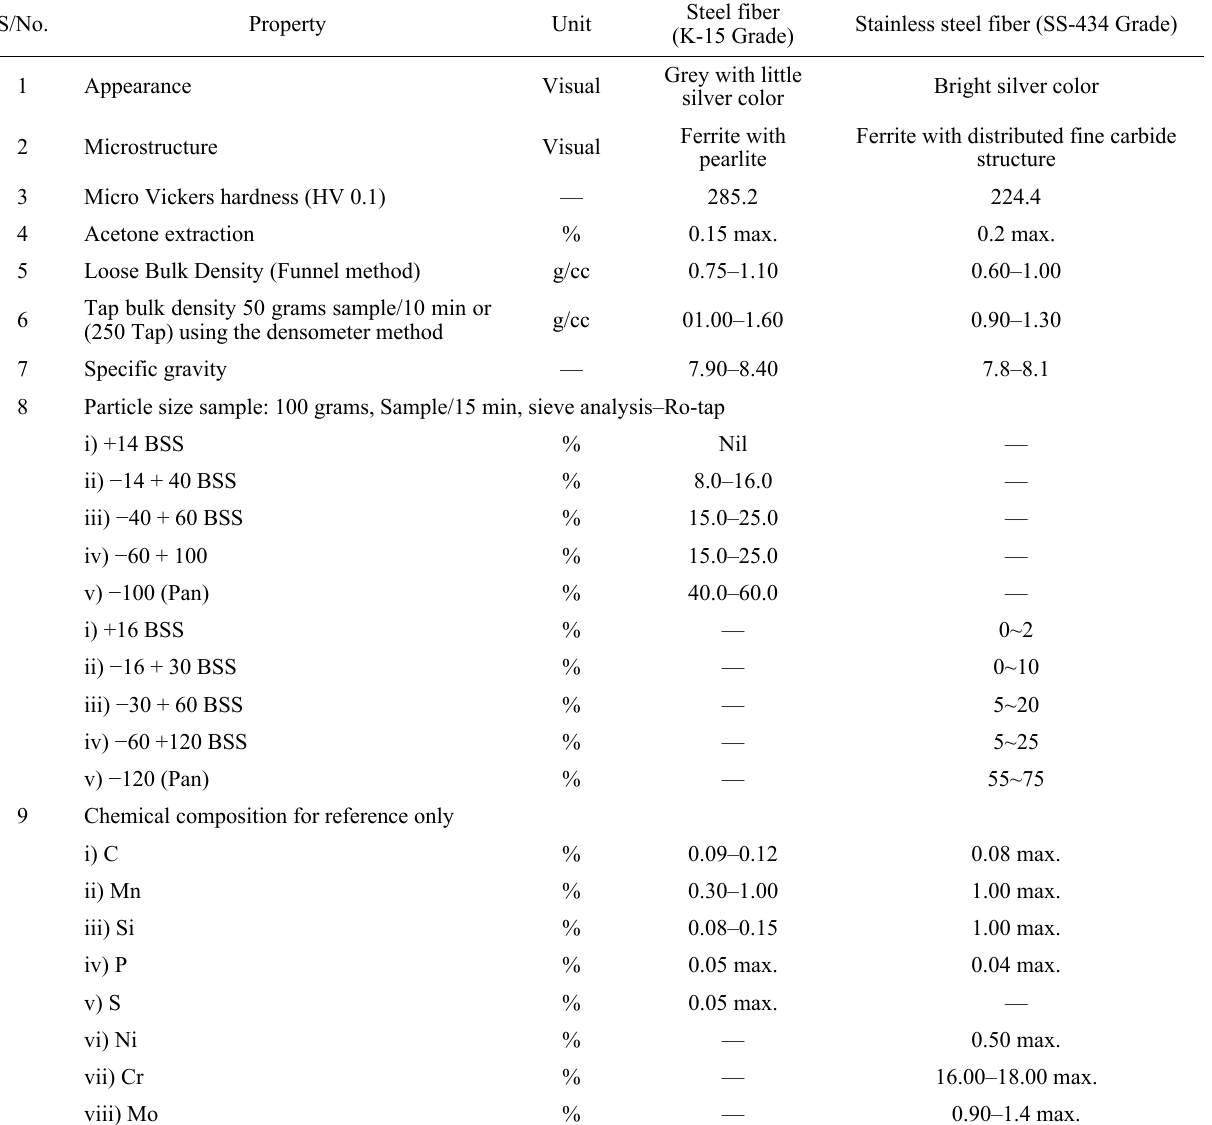
Table 1 Specification of steel fiber (K-15 Grade) and stainless steel fiber (SS-434 Grade).